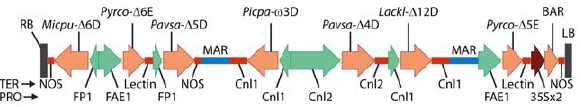
Figure 2. Construct map of pJP3416_GA7 left-right border (LB and RB) region. Abbreviations are: TER, terminator or polyadenylation region; PRO, promoter; NOS, Agrobacterium tumefaciens nopaline synthase terminator; FP1, Brassica napus truncated napin promoter; FAE1, Arabidopsis thaliana FAE1 promoter; Lectin, Glycine max lectin terminator; Cnl1 and Cnl2 denotes the Linum usitatissimum conlinin1 or conlinin2 promoter or terminator. MAR denotes the Rb7 matrix attachment region from Nicotiana tabacum and gene identities are given in the text and the Materials and Methods section.